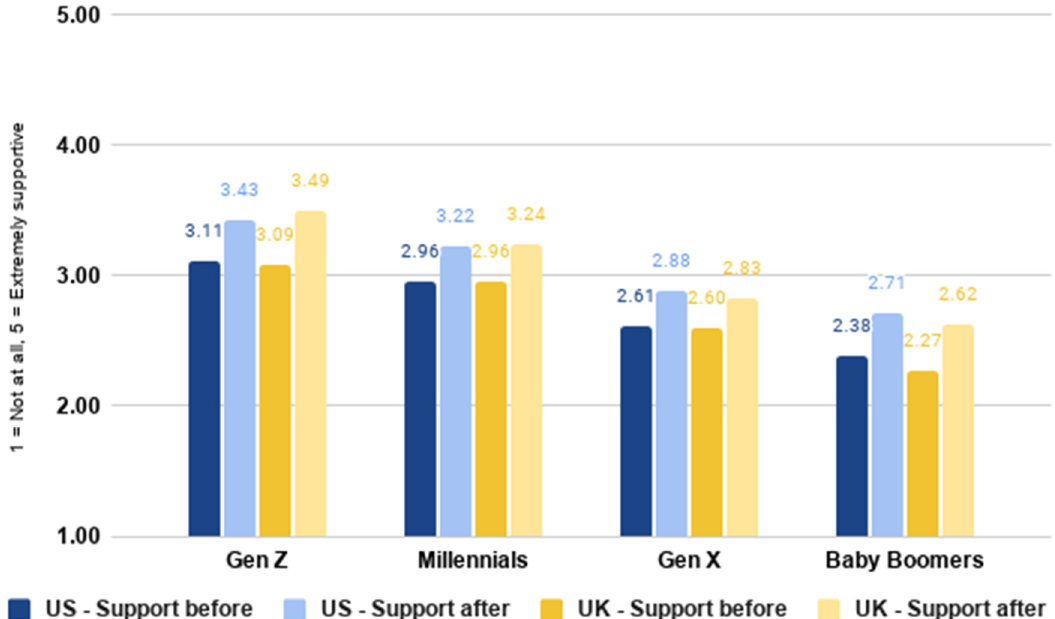
Figure 5. Level of support for cultivated meat before and after expanded technology description by generation.